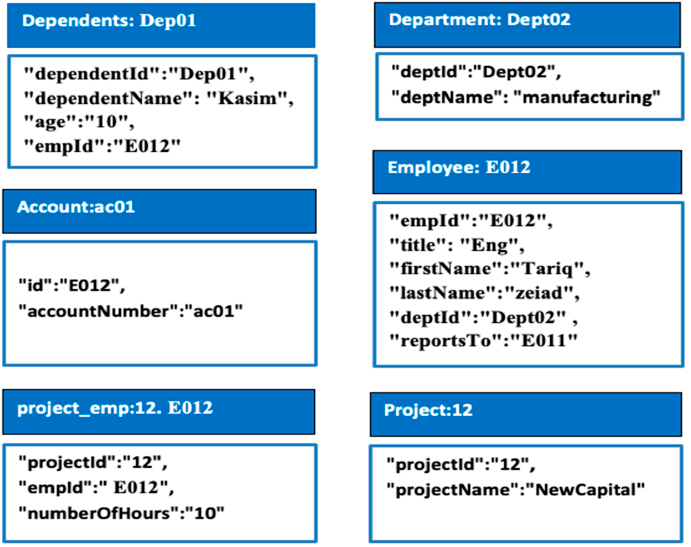
Figure 5. Key–value schema generated by applying rules 19 and 20 to Figure 2.